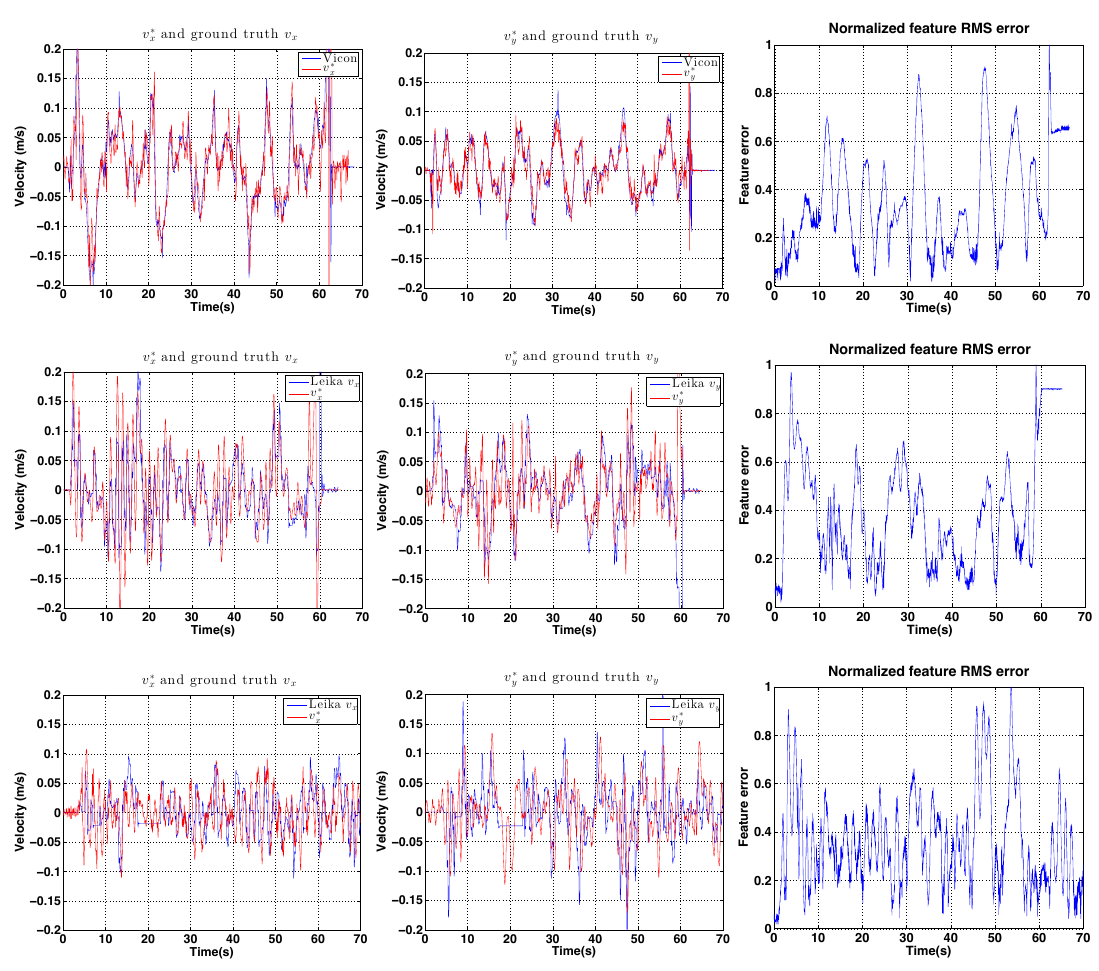
Figure 33. Experimental results for IBVS-based hovering: control demand. v ∗ and v ∗ ( middle column ) compared to ground truth. The first row is for indoor hovering while y the second and the third rows are for day and night-time outdoor hovering. Normalized root mean squared (RMS) image feature errors for each are shown in the ( right column